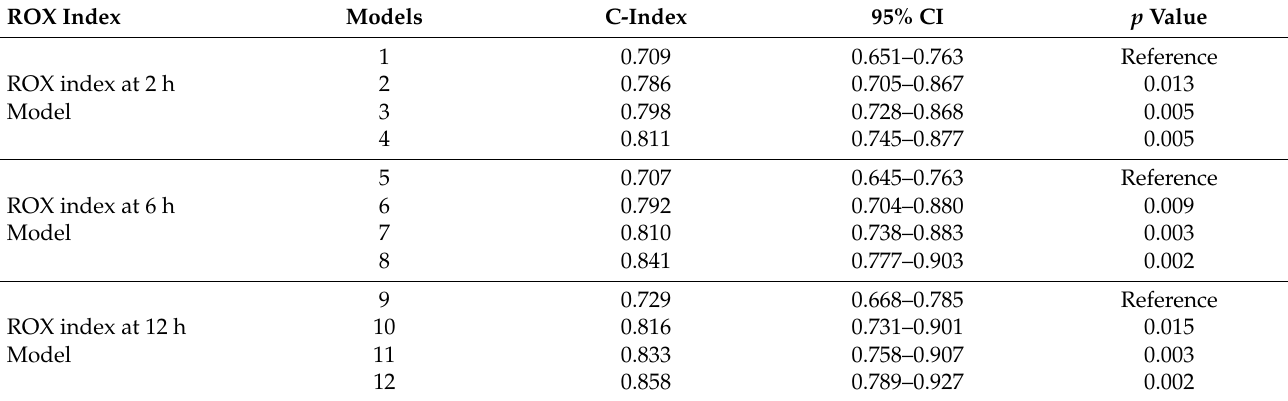
Table 4. Prognostic capabilities of models using the ROX index and potential factors for predicting HFNC